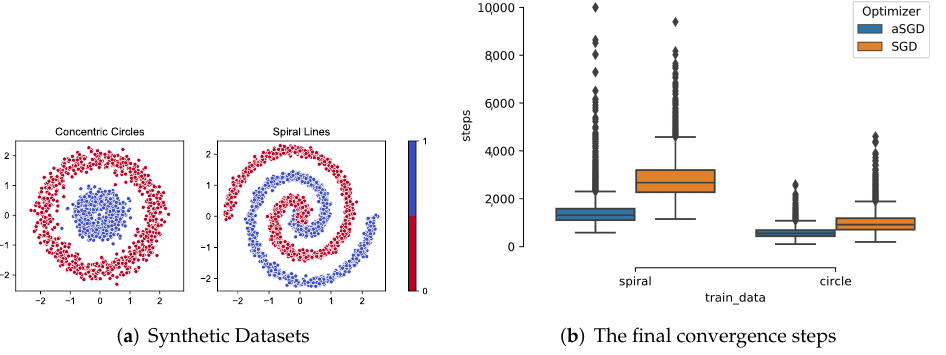
Figure 5. ( a ) Synthetic datasets and ( b ) the boxplot of final convergence steps of Experiment